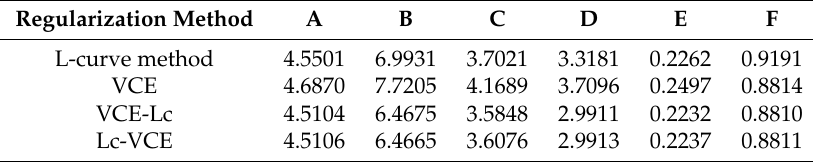
Table 7. RMS values (unit [m 2 /s 2 ]) of each method for different study cases using the CuP